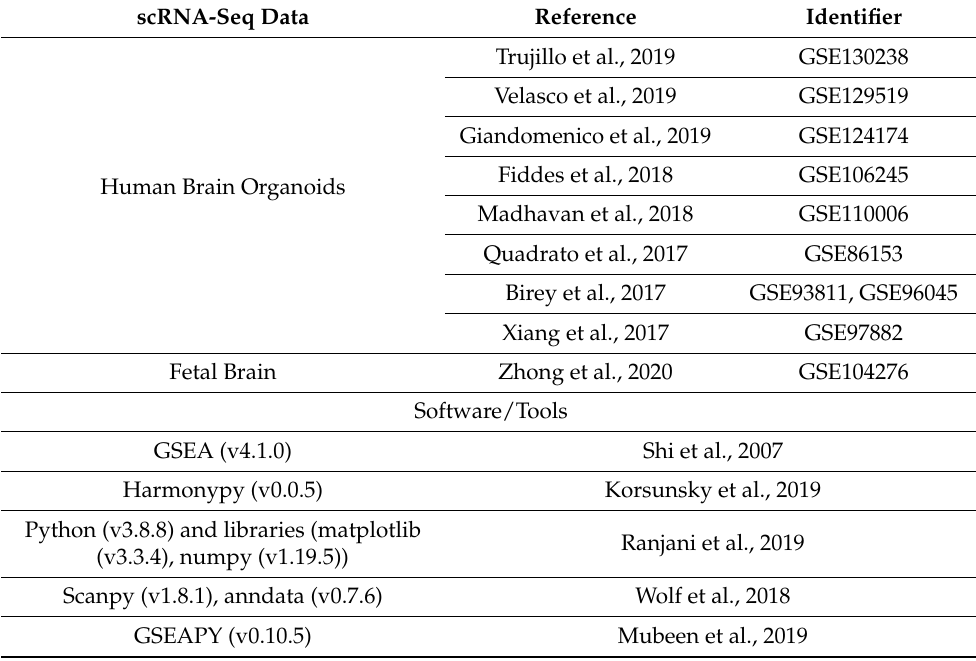
Table 1. Key resource table including tested datasets and software used for data